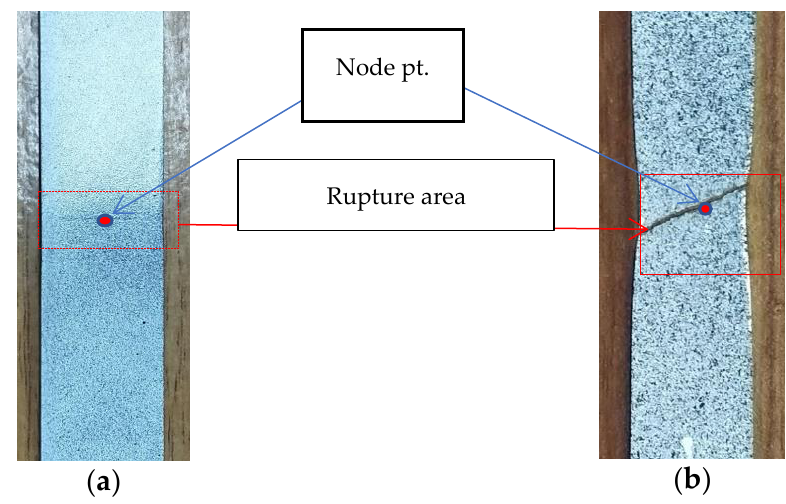
Figure 5. Tension test samples; ( a ) original sample and ( b ) sample after rupture. The simulation result was considered up to the point when the extensiometer displace- ment in the simulation reached the same value as in the experiment (i.e., the rupture point). The various stress–strain data obtained from the numerical simulation of the tensile test sample are presented in Figure 6. They indicate the distribution of (a) von-Mises stress, (b) maximum principal stress, (c) equivalent plastic strain, and (d) hydrostatic stress at the point of rupture. The load–extensiometer-displacement curve is presented in Figure 7. It indicates that there is good agreement between the experimental curve and the simulated curve. The maximum load value reached in experiment was 13,702 N and in the simulation it was 13,331 N, whereas the extensiometer displacement at the rupture point was 27 mm in both the experiment and the simulation.